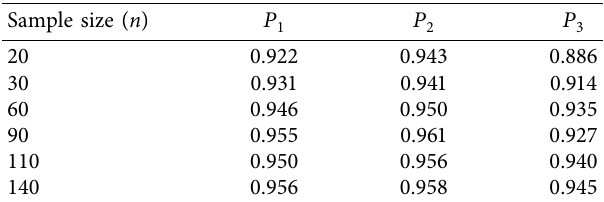
Figure 1: (a) MSE of Table 2: Coverage probabilities of 95% confidence intervals for the Table 3: Percentiles (2.5 and 97.5) of the pivotal quantities via the pivotal quantities based on the MLEs of parameters. MLEs and